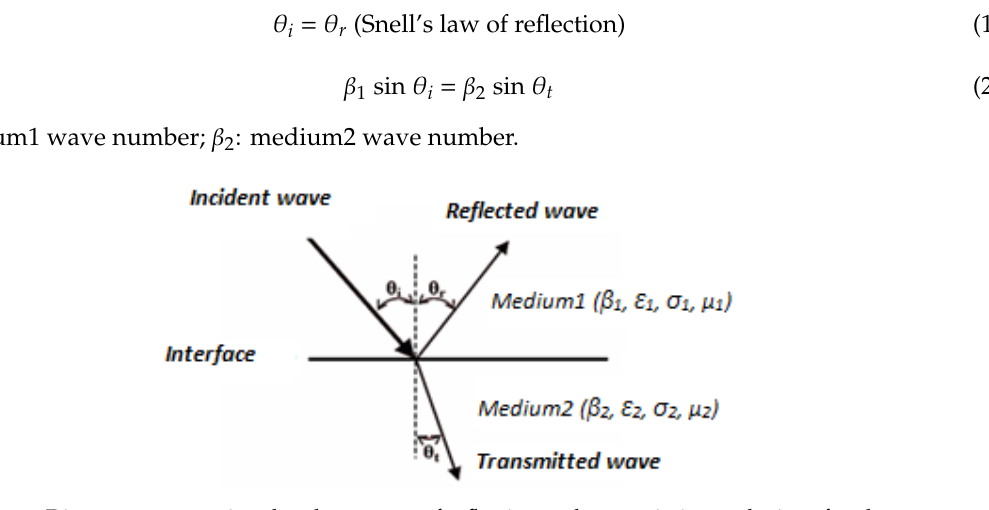
Figure 1. Diagram representing the phenomena of reflection and transmission at the interface between two media which represent different dielectric contrasts.